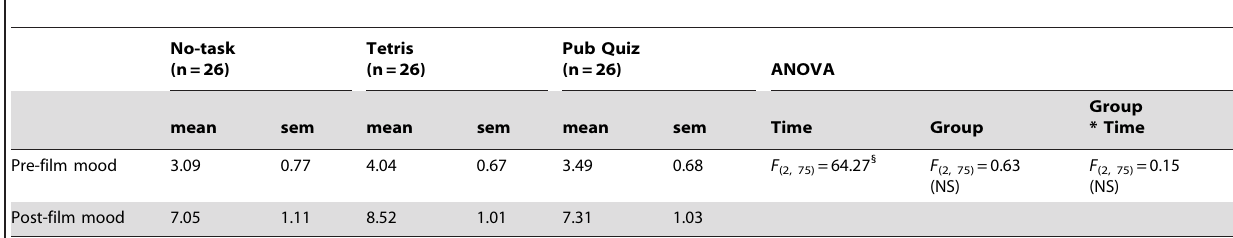
Table 7. Experiment 2 means and statistics for mood assessment (pre vs. post-trauma film) indicating equivalent deterioration in mood over the film across conditions.